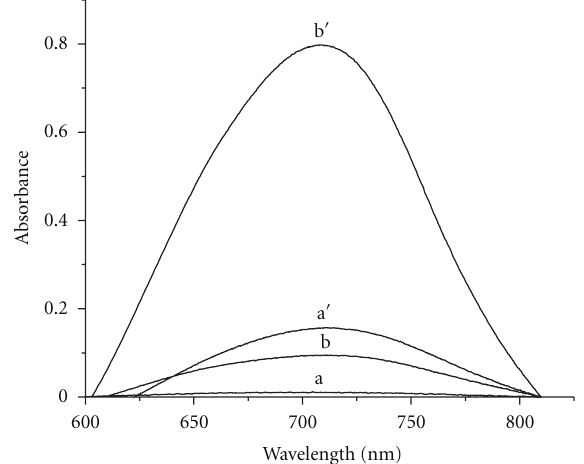
Figure 1: Absorption spectra. (a, b) are reagent blank and sample absorbance in aqueous phase. (a (cid:2) , b (cid:2) ) are reagent blank and sample absorbance in micellar